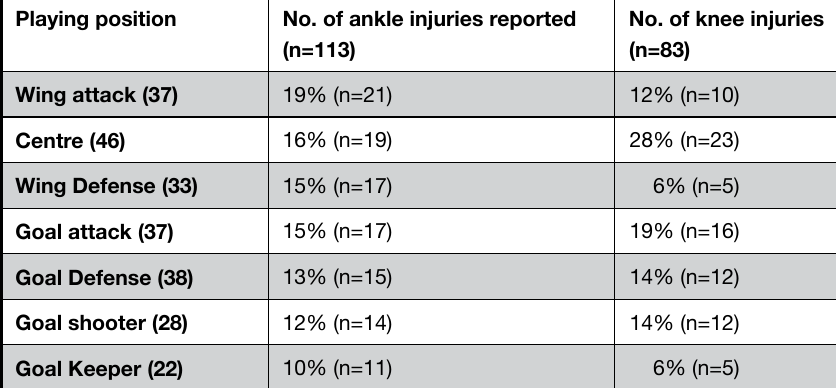
Table 3: reported ankle and knee injuries per playing position Playing position no. of ankle injuries